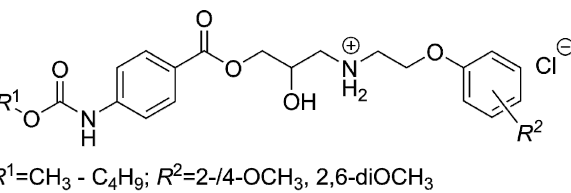
Figure 5. Chemical structure of 2-hydroxy-3-[(2-aryloxyethyl)amino]propyl-4-[(alkoxycarbonyl)amino]benzoates, which were efficient in vitro against M. avium subsp. paratuberculosis CIT03 strain.